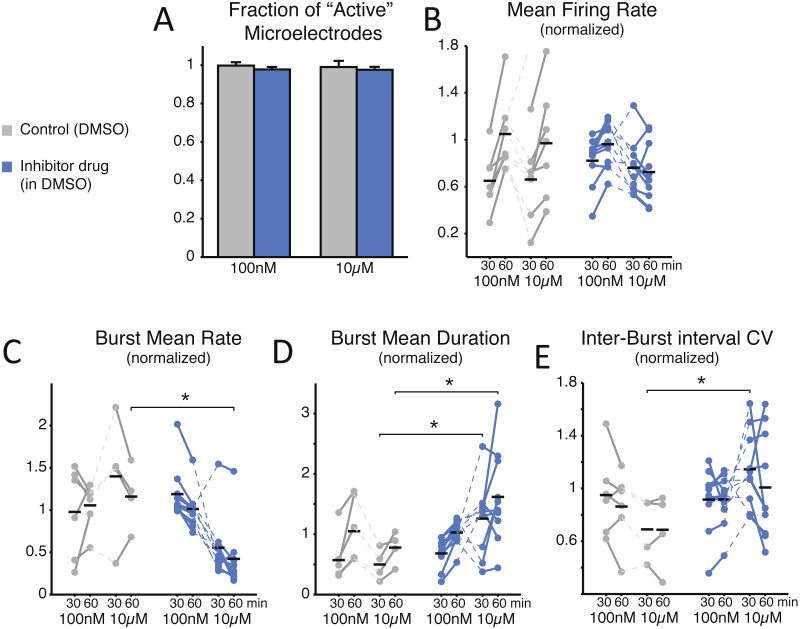
SP inhibition depresses network electrical activity, leading to a reduced NB occurrence rate, higher variability of inter-burst time intervals, and increased NB duration.The SP inhibition does not affect neural viability as the average number of active microelectrodes (A), normalised to baseline condition, is left unaltered (blue: treated MEAs, n = 10; grey: control MEAs, n = 7; error bars are the s.e.m.). The mean firing rate over the entire MEA is displayed in (B), normalised to and estimated during the first and last 30 min time intervals of bath-application of the SP inhibitor, showing no significant difference (black horizontal bars are the group averages). Instead, the inhibitor depresses the episodic occurrence of NBs, in cultures that display such a spontaneous activity pattern (10 treated and 6 controls at 100 nM, and 10 treated with 4 controls at 10 µM): the mean NB rate, normalised to baseline, decreases particularly at the high dose of the inhibitor (C). Correspondingly, the NB duration increases significantly (D) at the high dose. Finally, the coefficient of variation of the inter-burst time interval distribution (E), normalised to baseline, increases particularly at the high dose of the inhibitor.